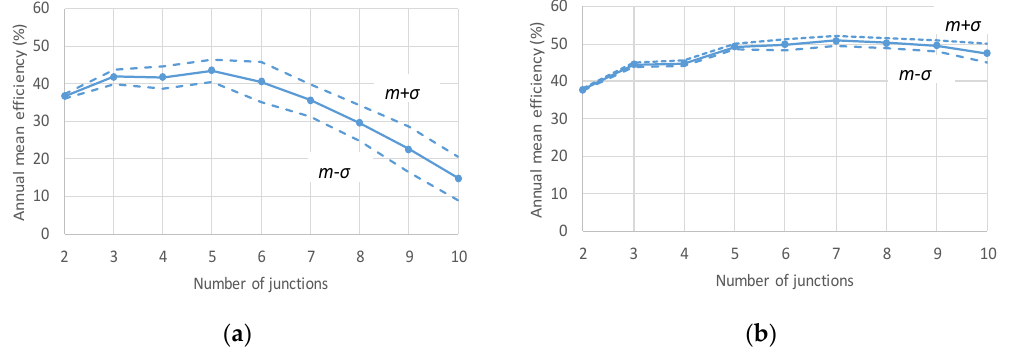
Figure 12. Optimization design result of the normal multi-junction solar cells (trend of an average of the annual average e ffi ciency by variation of the spectrum) under worst-case combination of climate, atmospheric conditions, latitude, and orientation angle. m indicates average of the annual average e ffi ciency, and σ indicates its standard deviation: ( a ) Normal multi-junction solar cell; ( b ) Super-multi-junction solar cell.